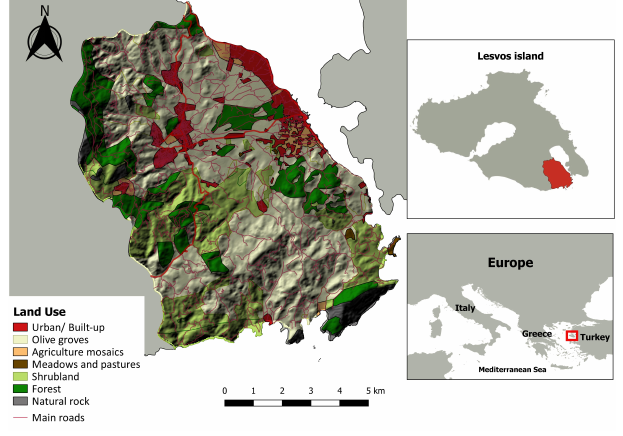
Fig. 3 . Location of the Gera study area on Lesvos island,